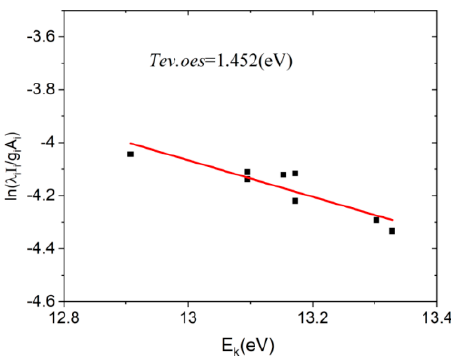
Figure 9. Liner fit for data of specified spectral lines driven by 800 W microwave at the pressure of 80 Pa.